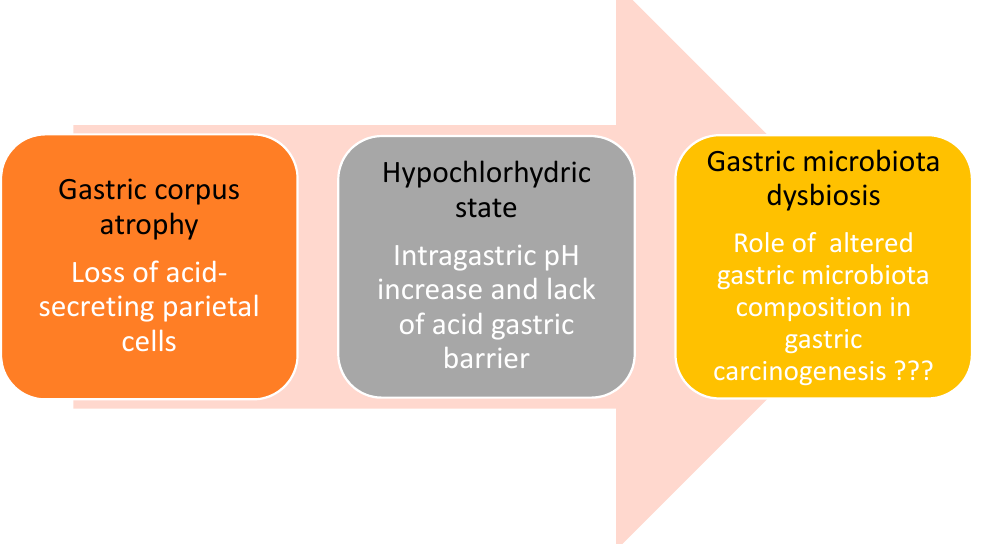
Figure 1. A possible link between autoimmune gastritis, hypochlorhydria, and gastric cancer may be hypothesized. Autoimmune gastritis, a corpus-restricted Hp-negative atrophic gastritis, is characterized by progressive immune-mediated atrophy of the oxyntic mucosa with subsequent loss of acid-secreting parietal cells, leading to hypochlorhydria. This changed intra-gastric microenvironment can make possible the survival of other bacteria than Hp possibly playing a key role in gastric